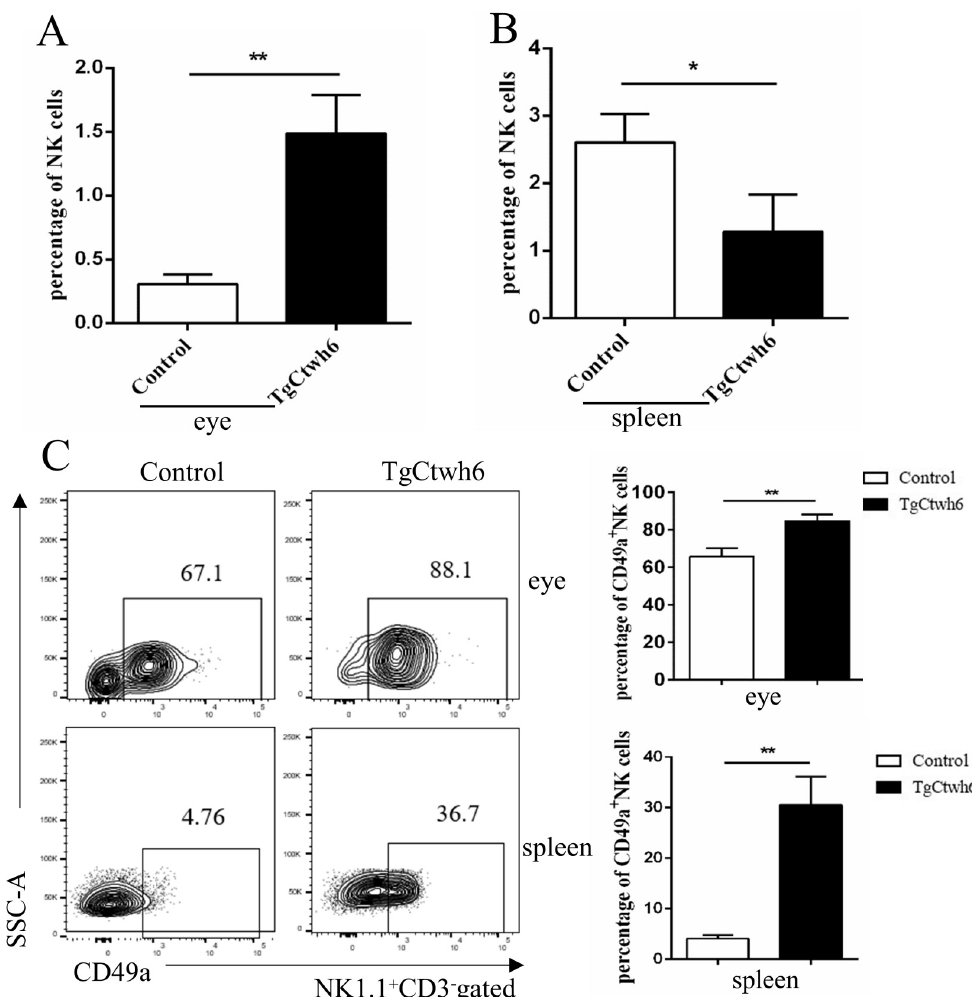
Fig 3. Representative flow cytometry plots for the analysis of NK cells and CD49a + NK in the eyes and spleen of uninfected and Day 30-infected mice. Percentage of NK (CD3 - NK1.1 + ) cells in lymphocytes in the infected eyes (A) and spleen (B) from representative murine OT and control mice. (C) The percentage of CD49a + NK (NK1.1 + CD3 - CD49a + ) cells was increased in infected eyes and spleen in the OT murine model. Pools of 10 mice were used and experiments were replicated three times. Values represent the mean ± SEM, � P < 0.05, �� P < 0.01. Lifitegrast treatment inhibited the protein expression of LFA-1 and ICAM- 1 in murine OT and NK cells Lifitegrast inhibits the binding of LFA-1 to ICAM-1. The signal transduction mediated by LFA-1 and ICAM-1 is involved in the adhesion, migration, and activation processes of lym- phocytes [18],which may decrease the production of LFA-1 and ICAM-1 in the OT murine model. Therefore, we used western blot analysis to determine the expression of CD11a, CD18 and ICAM-1 in ocular tissues. Compared to the vehicle-treated group, the eyes of the lifite- grast-treated group showed a marked decrease in LFA-1 and ICAM-1 protein expression (Fig 6A). Our results show that lifitegrast treatment decreased the expression of LFA-1 on CD3 − NK1.1 + cells (Fig 6B) and CD49a + NK cells (Fig 6C) in the Lifitegrast 1 group compared with that of Vehicle 1 group but failed to influence the expression of LFA-1 on CD3 − NK1.1 + cells and CD49a + NK cells in the Lifitegrast 2 group.